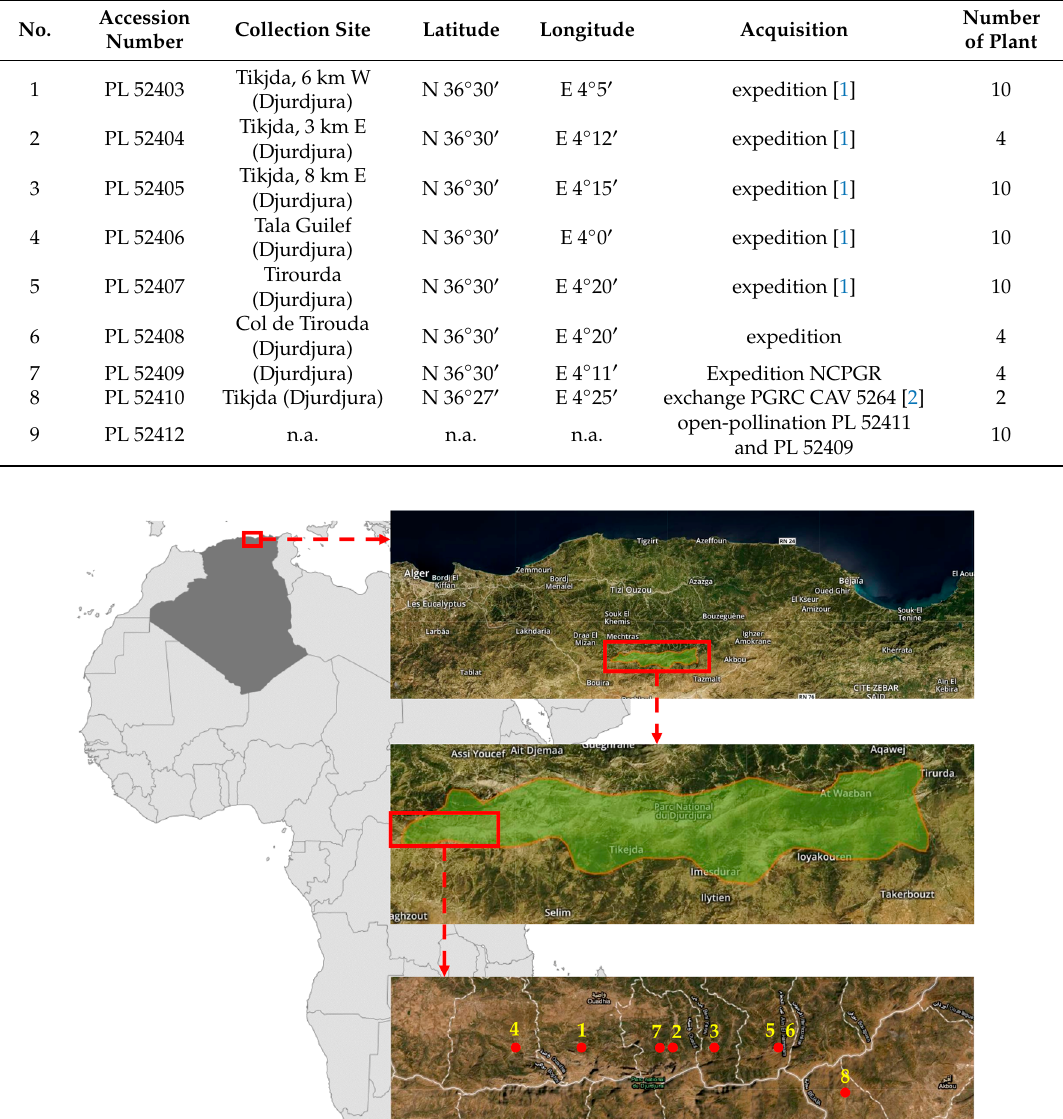
Table 1. List of A. macrostachya accessions preserved by the National Centre for Plant Genetic Resources (NCPGR) in Radzików, i.e., Polish gene bank.